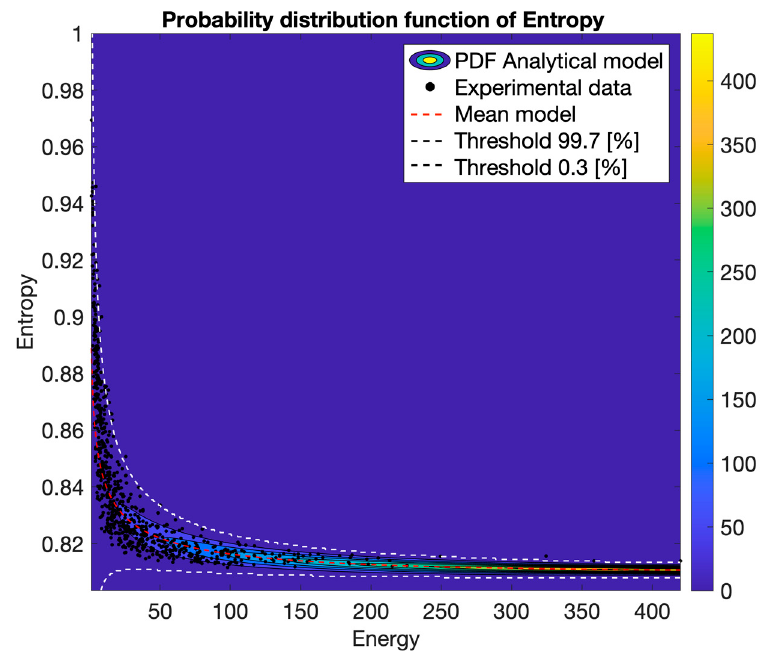
Figure 7. Entropy–energy dispersion and probability distribution function of the analytical model for a building complex near San Giovanni station.